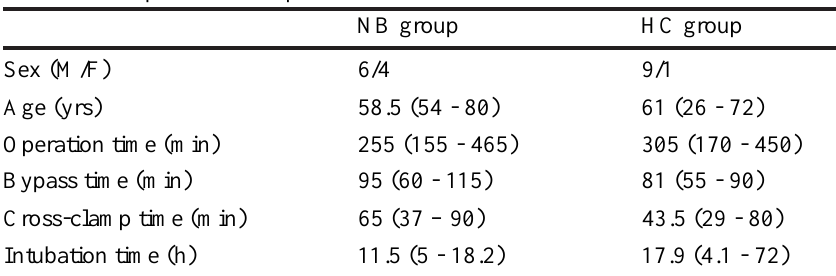
TABLE 1 - General and intraoperative characteristics of patient groups subjected to CPB surgery under different myocardial protection conditions and perfusion temperatures